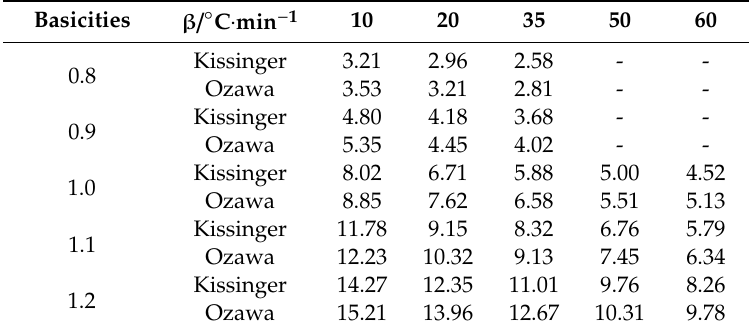
Table 6. Values of the Avrami exponent ( n ) using di ff erent